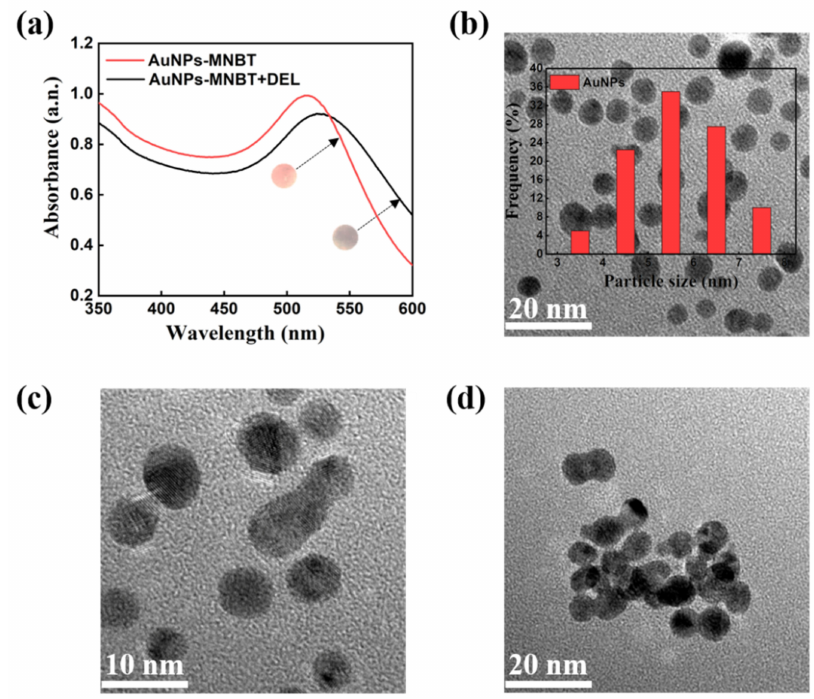
Figure 2. ( a ) UV–visible absorption spectra of MNBT-AuNPs and MNBT-AuNPs-DEL. ( b , c ) TEM images (insert is the particle size distribution) of MNBT-AuNPs and ( d )